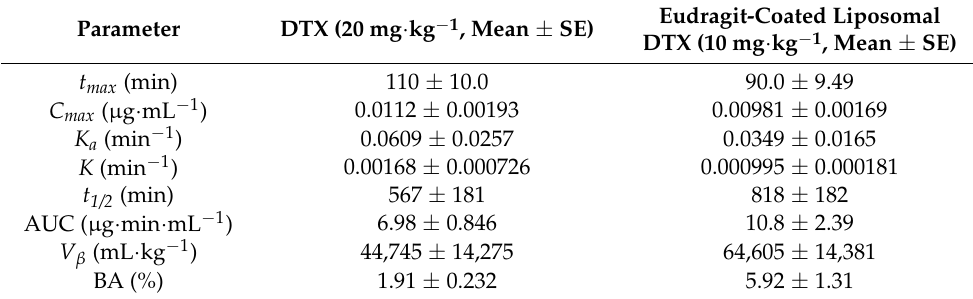
Table 3. Pharmacokinetic parameters after oral administration of free docetaxel (DTX) (20 mg · kg − 1 ) and Eudragit ® -coated liposomal DTX (10 mg · kg − 1 ) (reproduced with permission from [97], Copy- right 2018 Springer